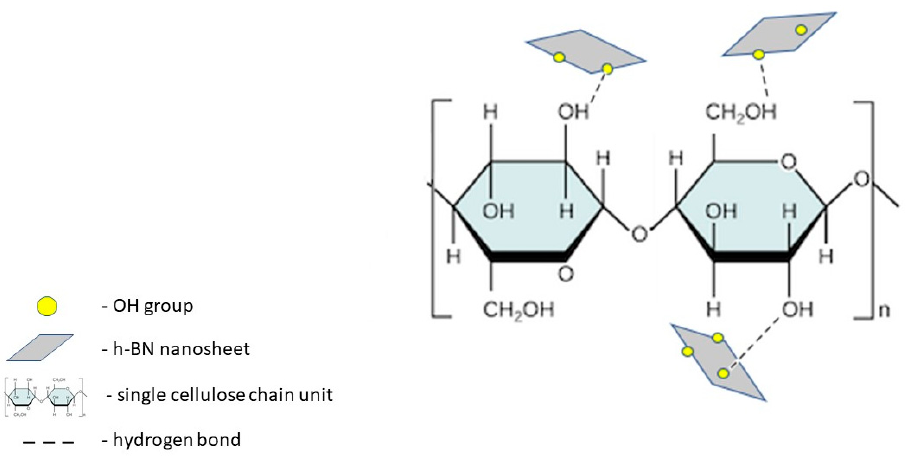
Figure 1. Schematic illustration of the interaction between cellulose and h-BN-OH via hydrogen bonding.